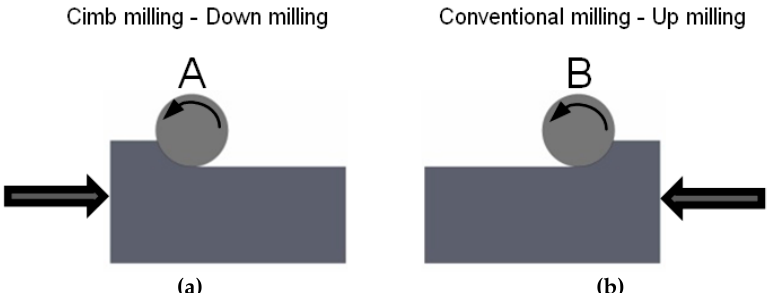
Figure 2. Schematic drawing of ( a ) machined workpiece (units in mm), ( b ) measured position angles.